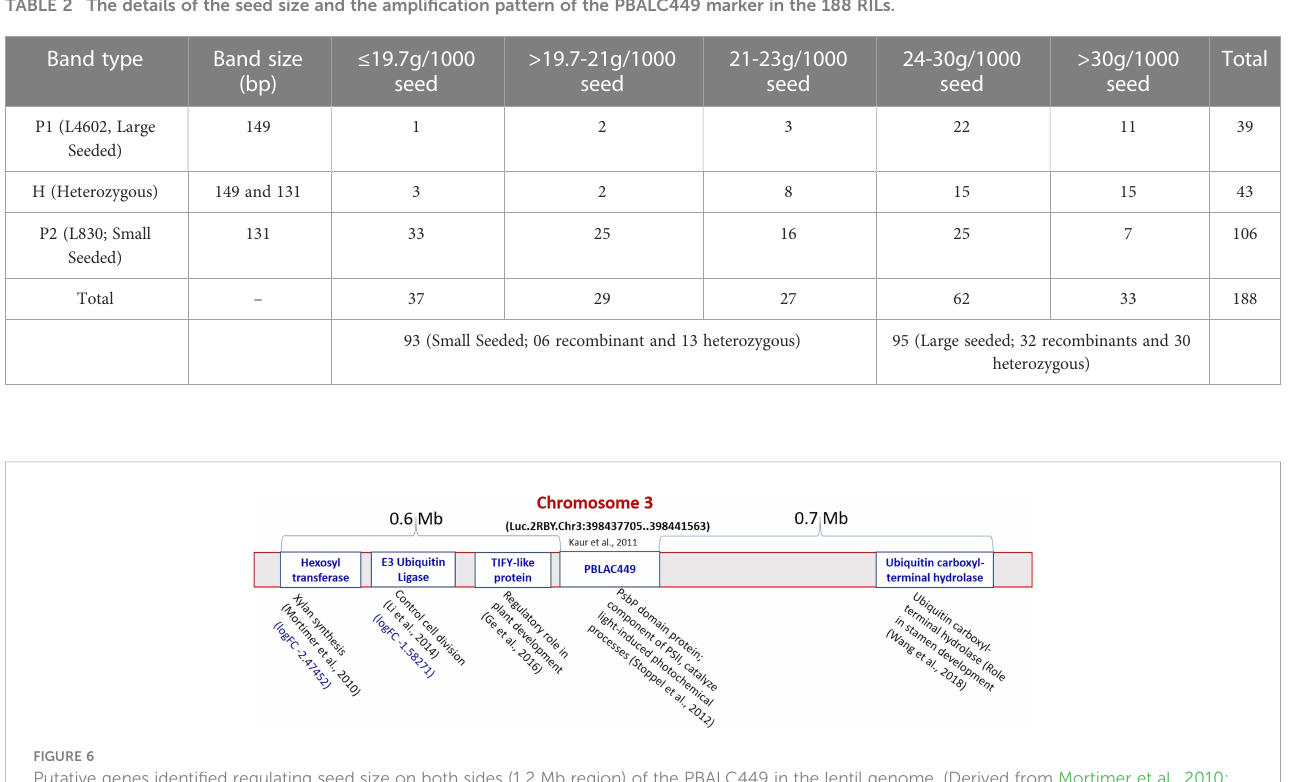
TABLE 2 The details of the seed size and the ampli fi cation pattern of the PBALC449 marker in the 188 RILs. Band type